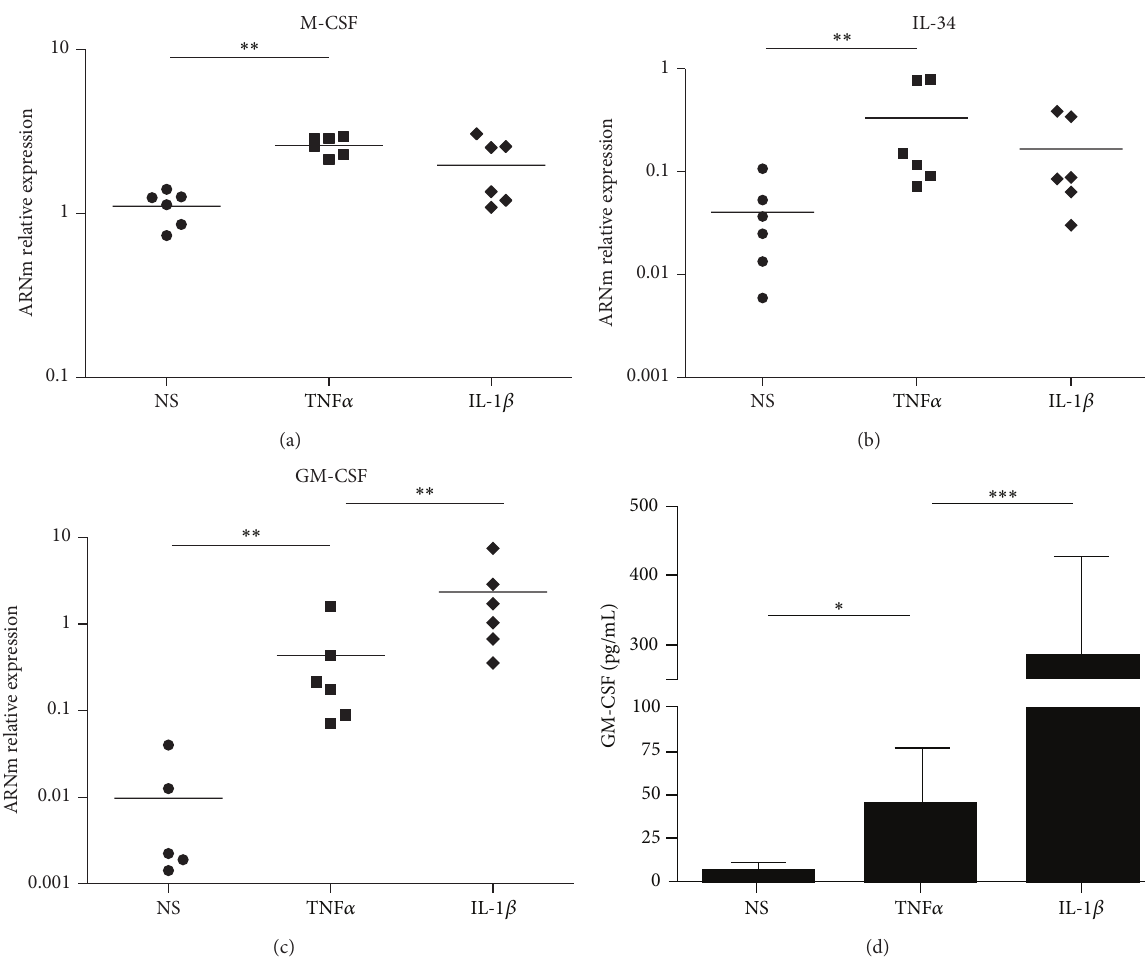
Figure 2: Effect of IL-1 𝛽 and TNF 𝛼 on M-CSF, IL-34, and GM-CSF expression in RA SF . SF were stimulated by IL-1 𝛽 (25 ng/mL) or TNF 𝛼 (25 ng/mL) for 24 hours. (a)–(c) RNA was harvested and a qPCR for M-CSF, IL-34, and GM-CSF expression was performed. Results are given as the relative expression using hHPRT gene as housekeeping gene. The bars represent the mean and each plots one biological replicate ( 𝑛 = 6 patients). (d) GM-CSF concentration (pg/mL) was assessed by ELISA. Results are given as the mean ( ± SEM). ∗ 𝑃 < 0.05 ; ∗∗ 𝑃 < 0.001 ; ∗∗∗ 𝑃 < 0.0001